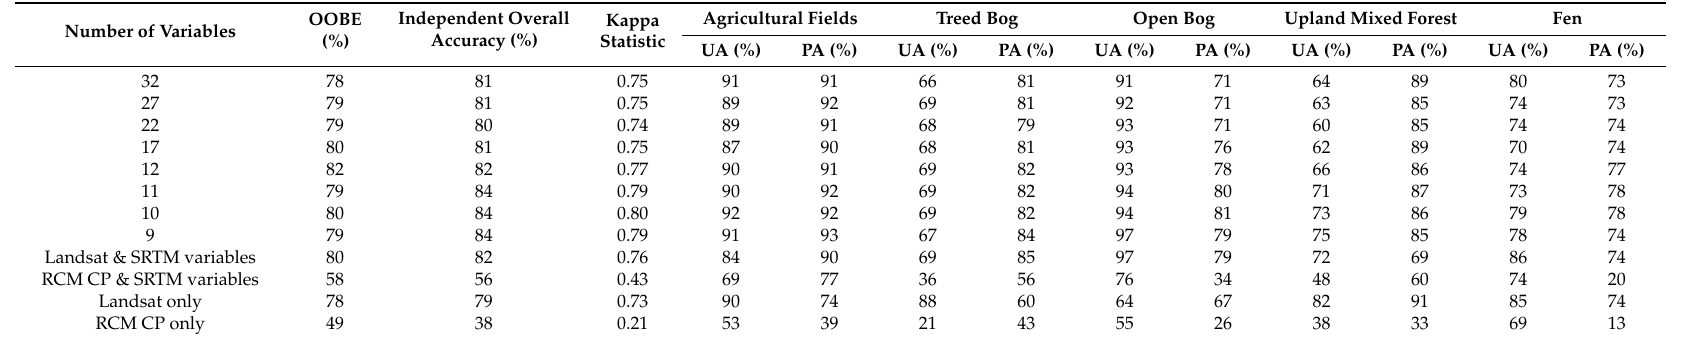
Table A3. Statistical results from the RCM CP NESZ − 25 dB (2 May 2014), Landsat-8 (24 April 2014), and SRTM variables spring model. The first iteration was run with all 50 variables, and variables ranked to be unimportant were then removed until 9 variables remained. The final variables in the model with the highest independent overall accuracy (10 variables) in order of decreasing importance were the seven Landsat-8 bands, m-delta surface, Intensity from Shannon Entropy, and SRTM